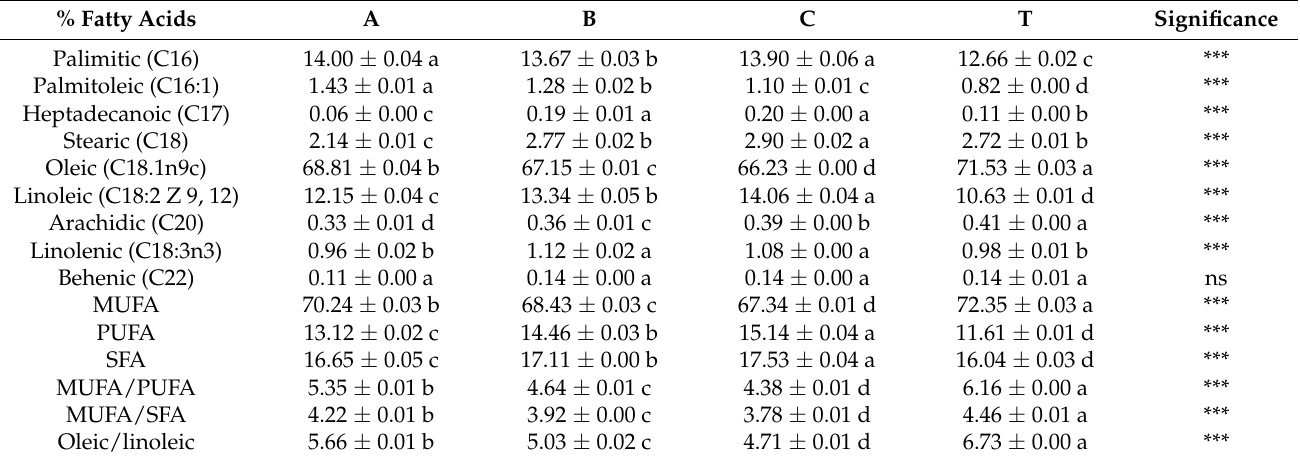
Table 5. Fatty acid composition of analyzed oils treated with three biostimulants: A (tropical plants extract), B (glycine betaine), and T ( Trichoderma ) all compared with C